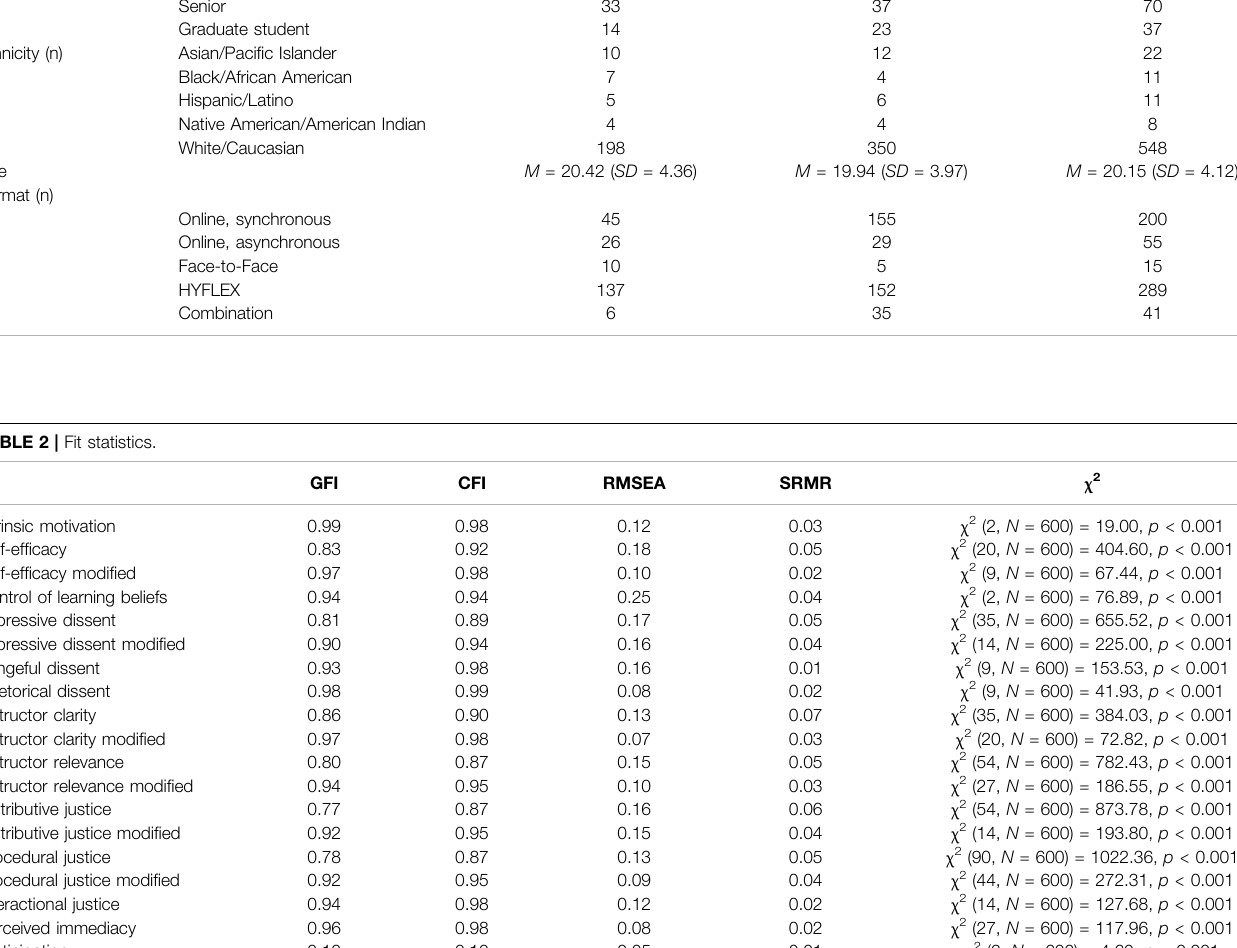
TABLE 1 | Demographic characteristics.